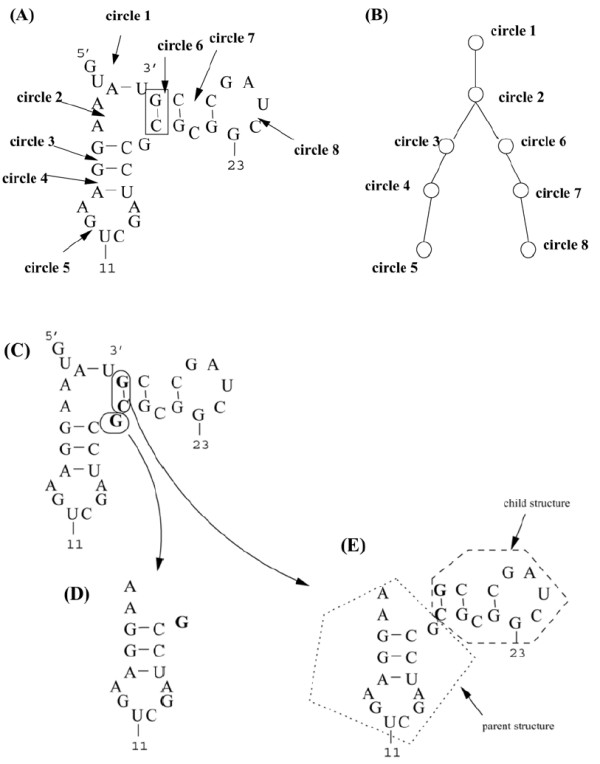
RNA structure decomposition (A-B) and Partial structure determination (C-E). (A) A hypothetical RNA secondary structure is decomposed into a set of circles. (B) The circles are organized into a hierarchical tree. As shown, circle 8 contains only one pair of bases that are bonded with each other; therefore it corresponds to a loop. Circle 7 contains two pairs of bases that are bonded with each other respectively and also contains a single base (nucleotide C); therefore circle 7 corresponds to a bulge. Circle 6 corresponds to a stem of length two since it does not contain any single base. Circle 2 contains more than two pairs of bonded bases; therefore it corresponds to a junction. (C) A hypothetical RNA secondary structure is used to illustrate how partial structures are determined. (D) The partial structure for the single base G in boldface is shown. (E) The partial structure for the base pair C-G in boldface consists of two parts, a parent structure and a child structure. The base pair itself is included in the child structure.